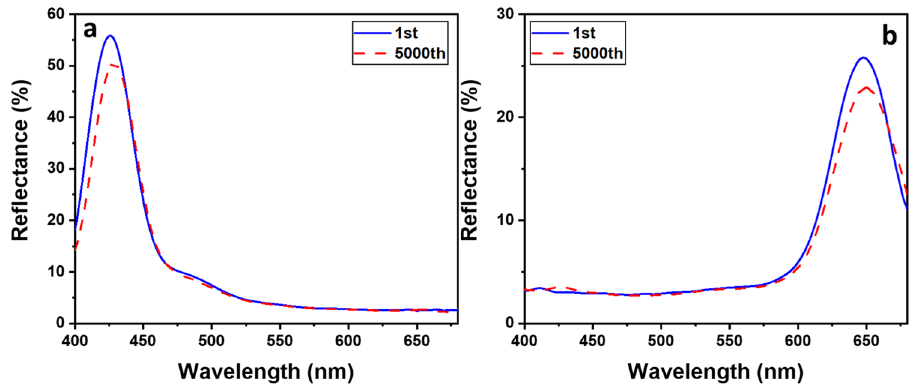
Figure 11. Reflectance spectra of sensor substrate after first cycle and 5000th cycle of stretching for ( a ) 0% and ( b ) 50%